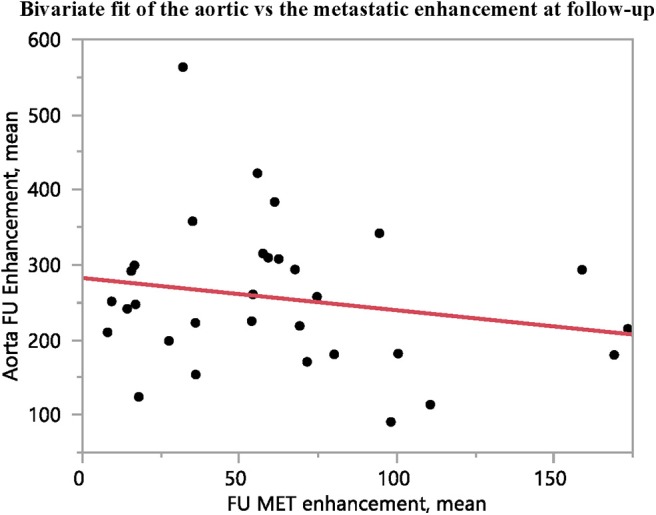
The contrast-enhancement in the abdominal aorta at the level of the coeliac trunk shows no correlation to the contrast-enhancement of the metastases at follow-up (n = 31, R2 = 0.04, p = 0.28).